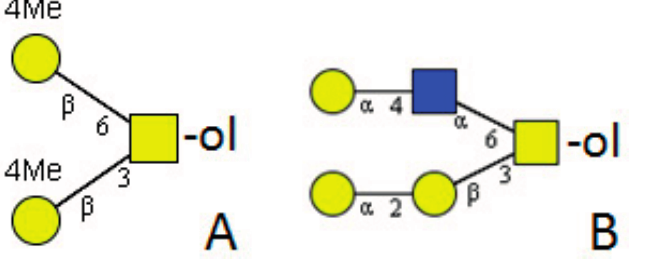
Figure 6. Examples of O- glycans from gastropod origin. ( A ) Arion lusitanicus [100] and ( B ) Conus consors